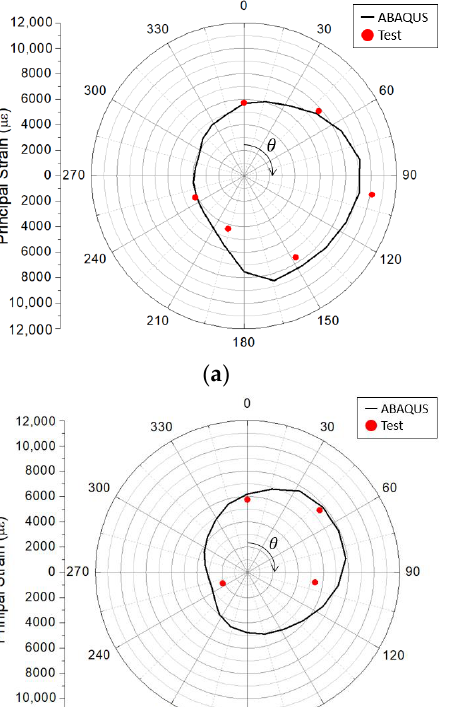
Figure 9. Loading steps of finite element analysis.